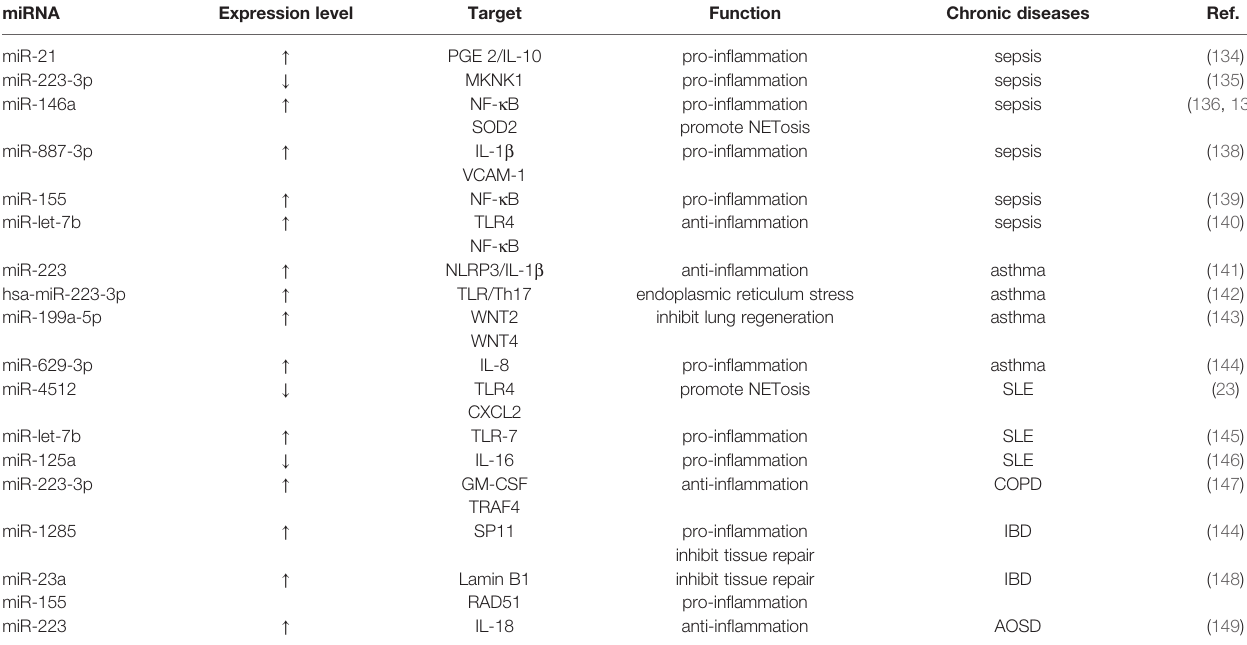
TABLE 1 | miRNAs regulate neutrophil-involved chronic diseases. miRNA